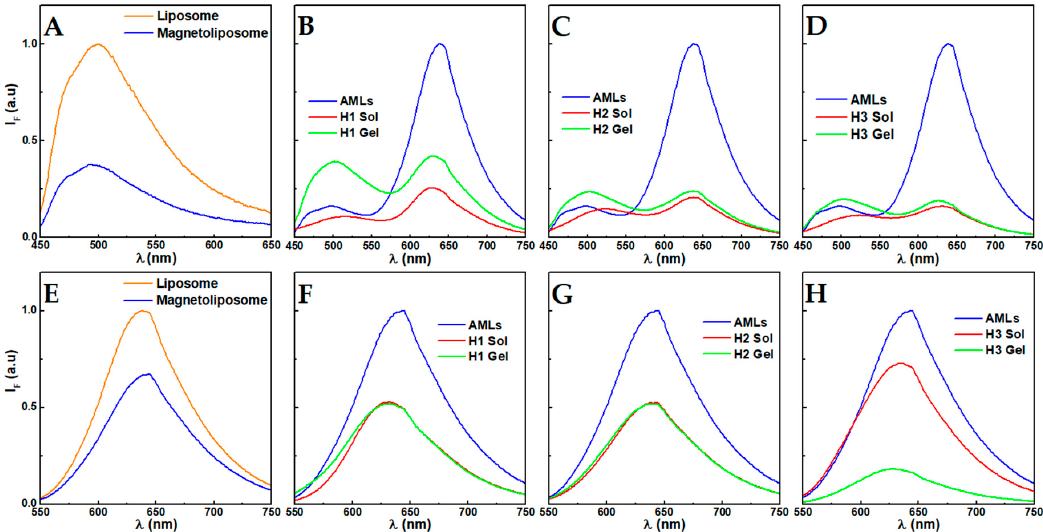
Figure 3. ( A ) Fluorescence emission spectra of curcumin in aqueous magnetoliposomes and liposomes of DPPC ( λ exc = 420 nm, [curcumin] = 1 × 10 − 6 M). ( B – D ) Fluorescence emission spectra of